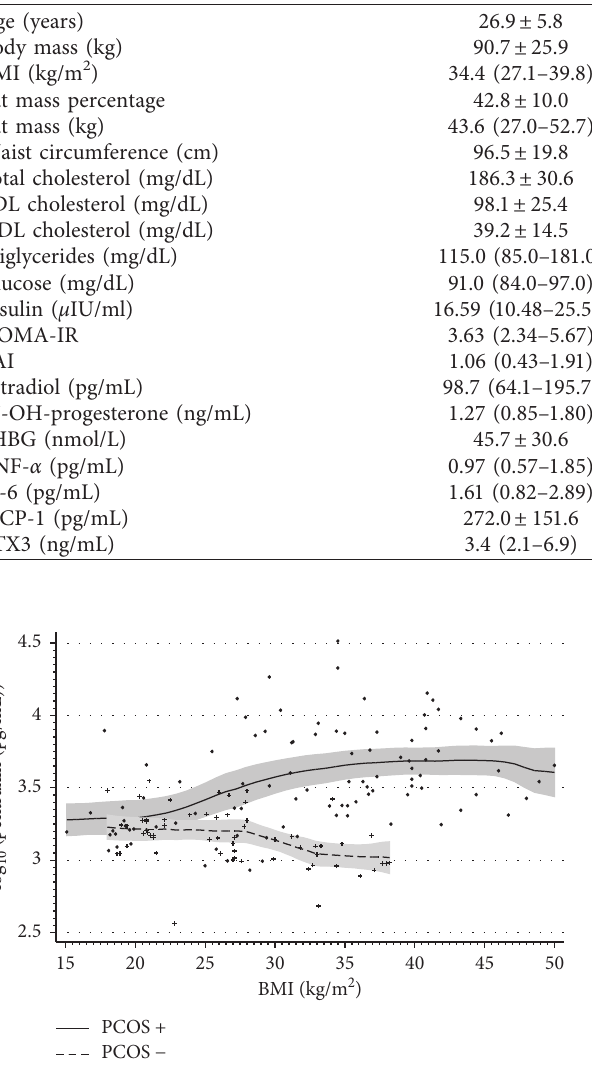
Figure 1: The relationship between PTX serum levels and BMI in PCOS and non-PCOS groups. Gray areas depict 95% confidence